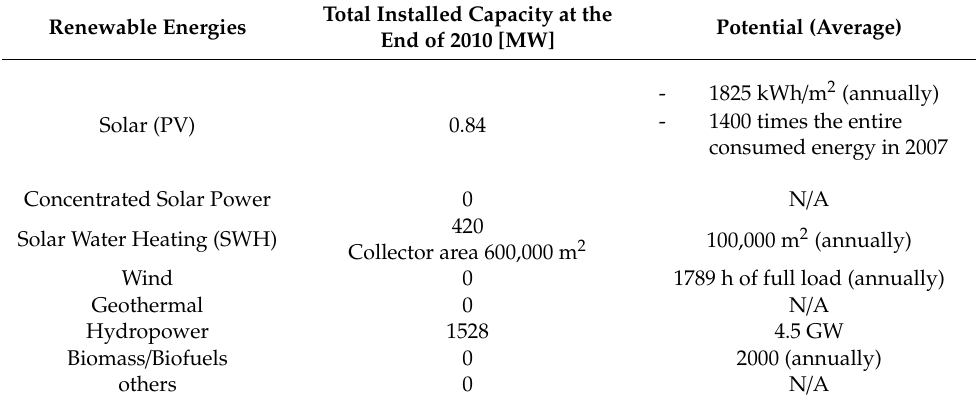
Table 4. Total installed capacity and estimated potential of renewable energies in SEPS at the end of 2010. Renewable Energies